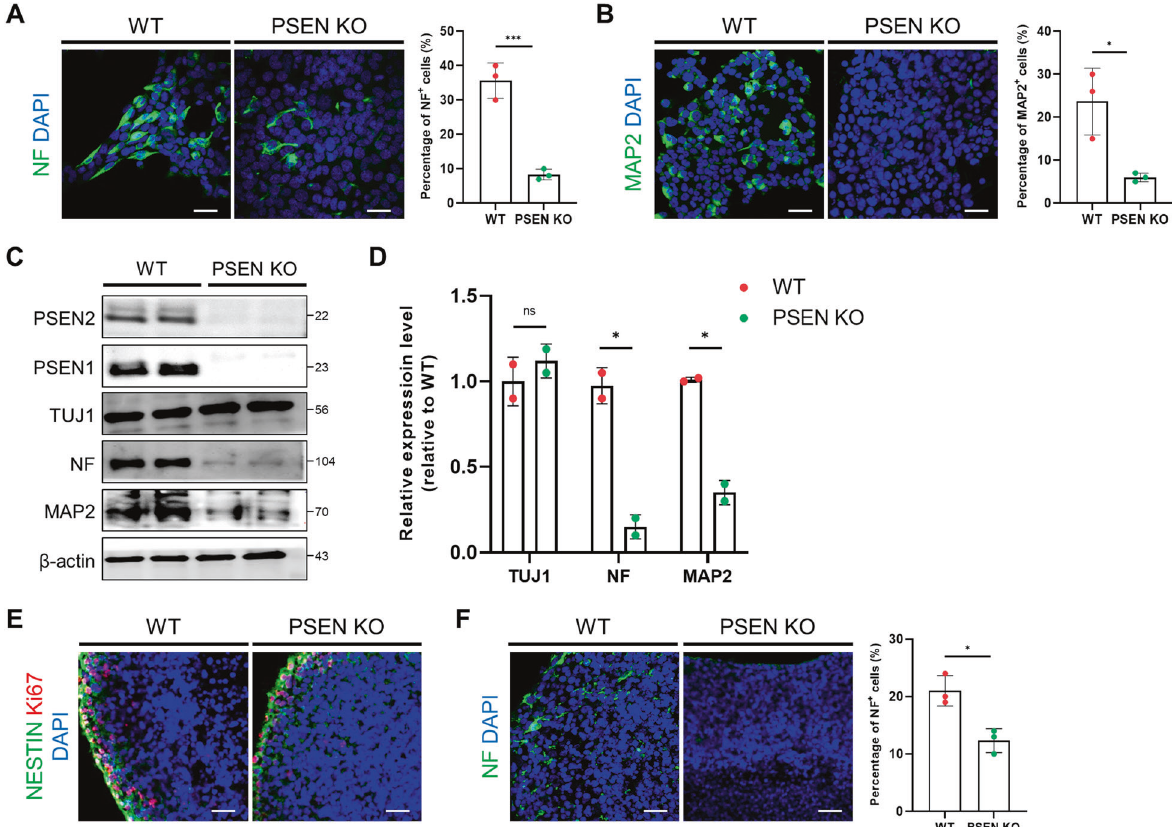
Fig. 6 Neuronal differentiation was downregulated in 2D and 3D cultures of PSEN KO-iNSCs. A Representative images showing NF (neuro fi lament) in WT- and PSEN KO-iNSCs and quanti fi cation of the expression levels after neuronal differentiation for 7 days. Scale bars, 50 µm. B Representative immuno fl uorescence images showing MAP2 in WT- and PSEN KO-iNSCs and quanti fi cation of the expression levels after neuronal differentiation for 7 days. Scale bars, 50 µm. C Relative levels of proteins implicated in neuronal markers in WT- and PSEN KO- iNSCs after neuronal differentiation for 7 days. D Quanti fi cation of the levels of TUJ1, NF, and MAP2. E Representative immuno fl uorescence images showing the neural progenitor markers (NESTIN, Ki67) in WT and PSEN KO organoids at day 28. Scale bars, 50 µm. F Representative immuno fl uorescence images showing NF in WT and PSEN KO organoids at day 28. Scale bars, 50 µm. Quanti fi cation of the protein levels in PSEN KO organoids compared to WT organoids. Statistical analysis was performed by Student ’ s t -test. n.s not signi fi cant and * P < 0.05. The results are presented as the means ±